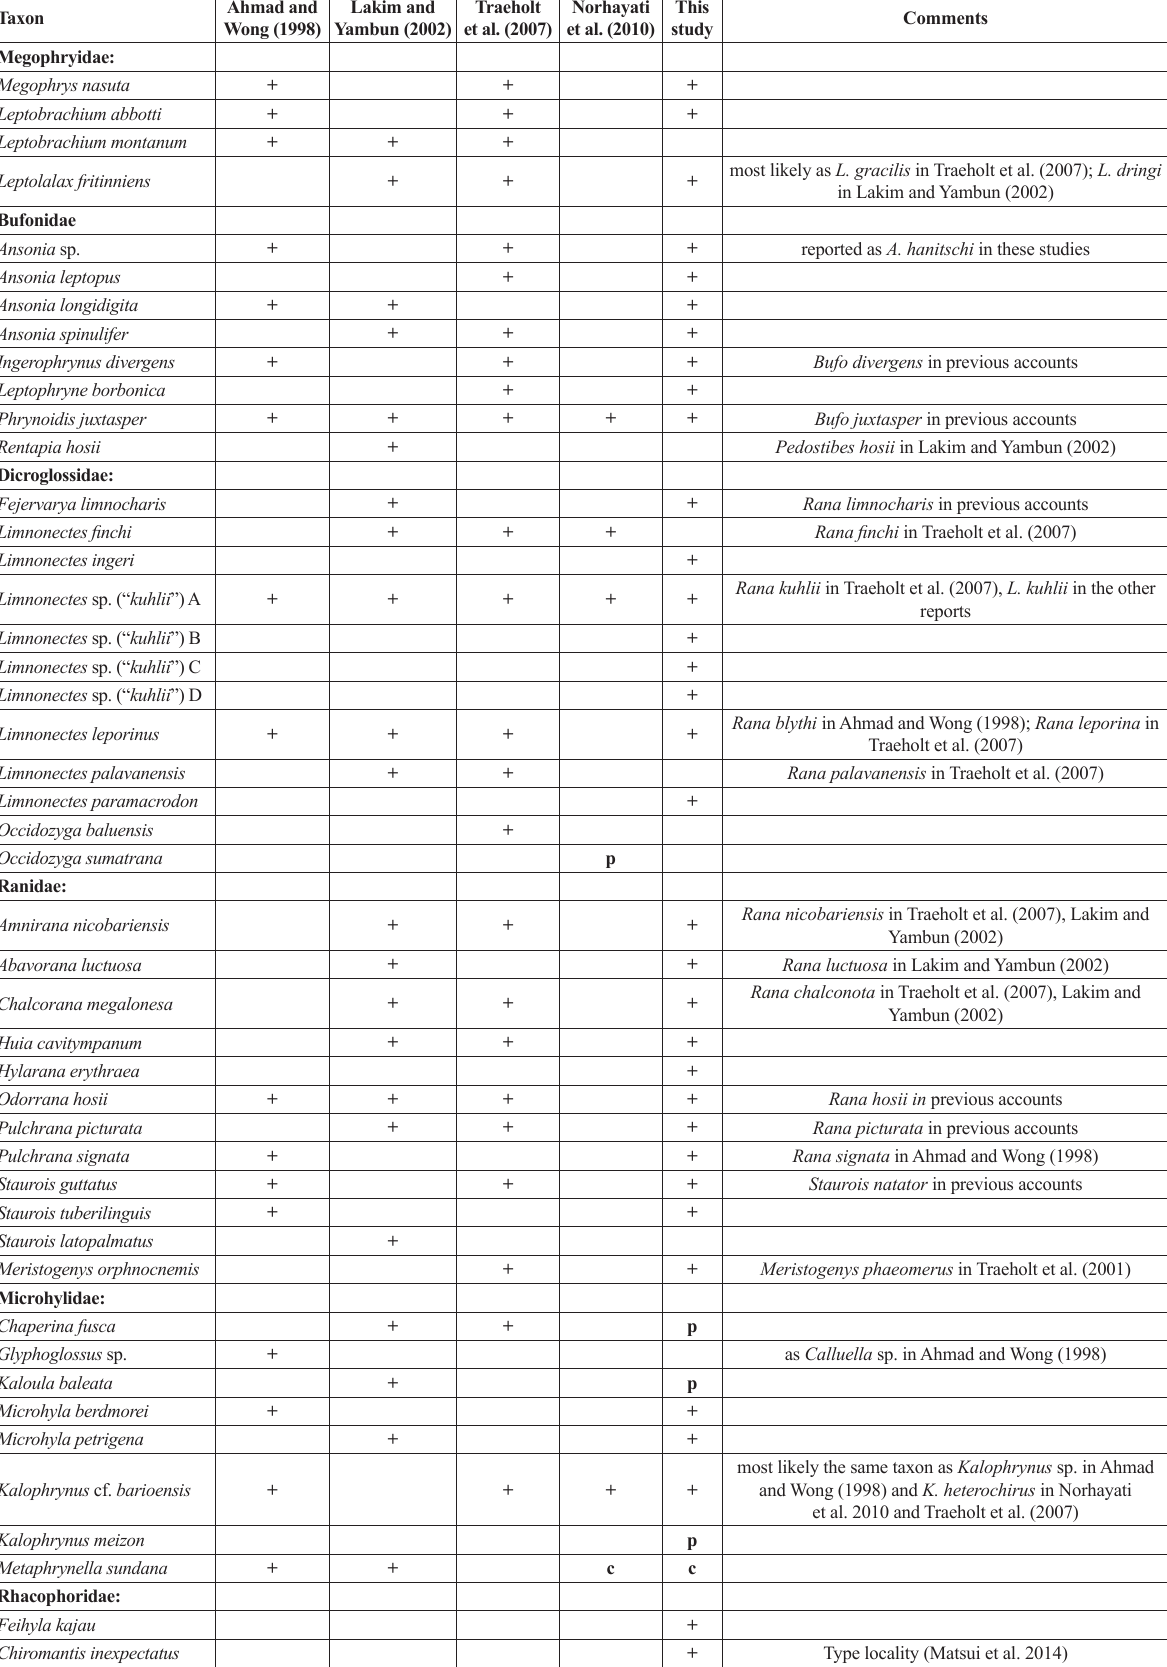
Table 2. Updated species list for MBCA. See text for more details. + = recorded species; c = identification by call; p = photo- graphic